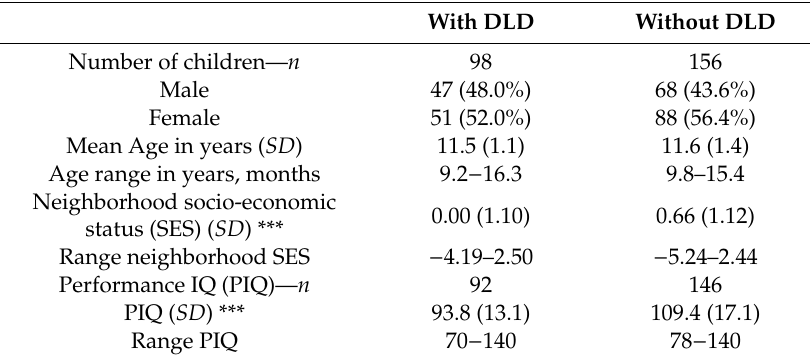
Table 1. Characteristics of participants at Time 1 for children with and without Developmental Language Disorder